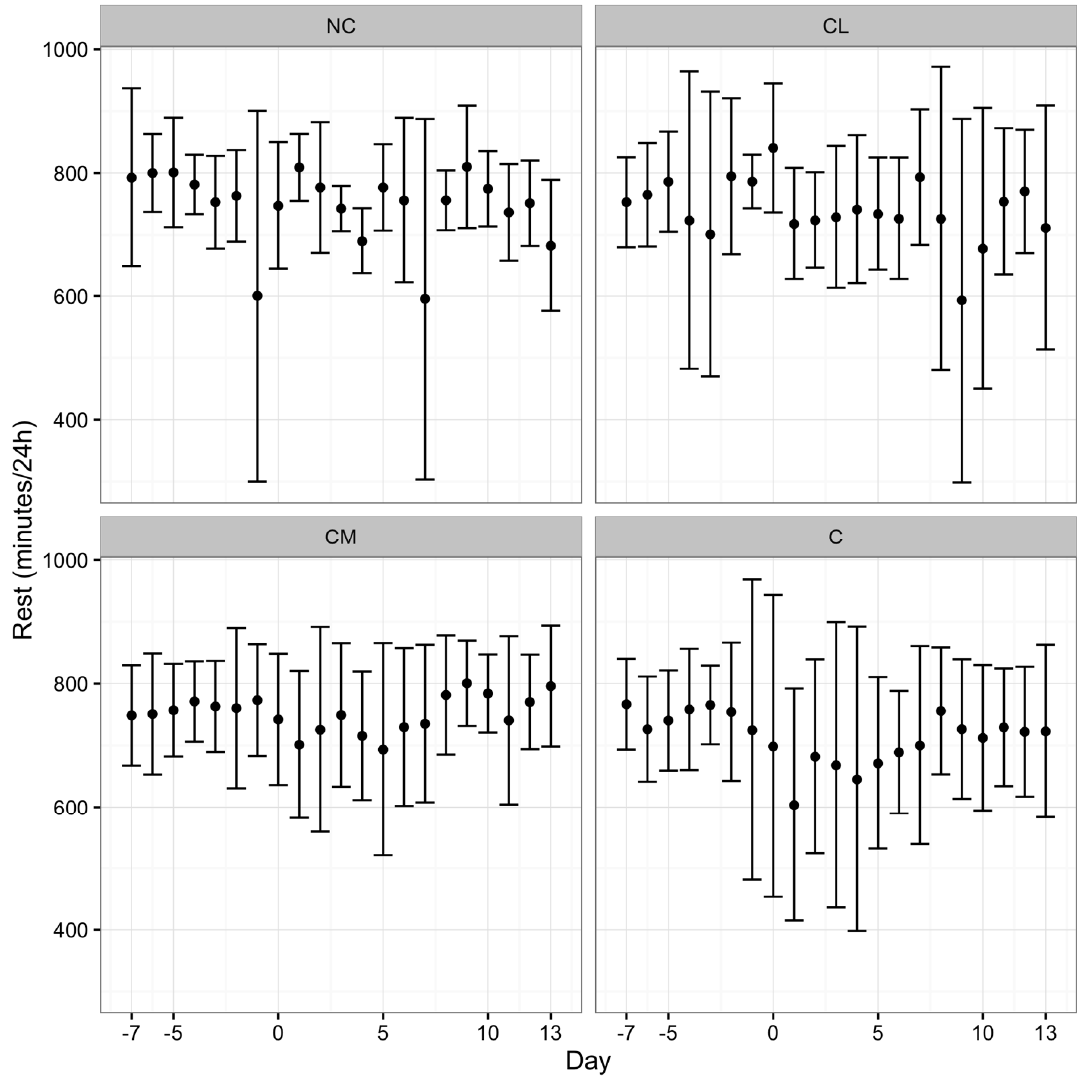
Figure 2. Mean ( ± SD) rest (min/24 h) from − 7 days prior to surgery to 13 days after surgery. CL = castration with lidocaine, CM = castration with meloxicam, C = castration, NC = no castration.